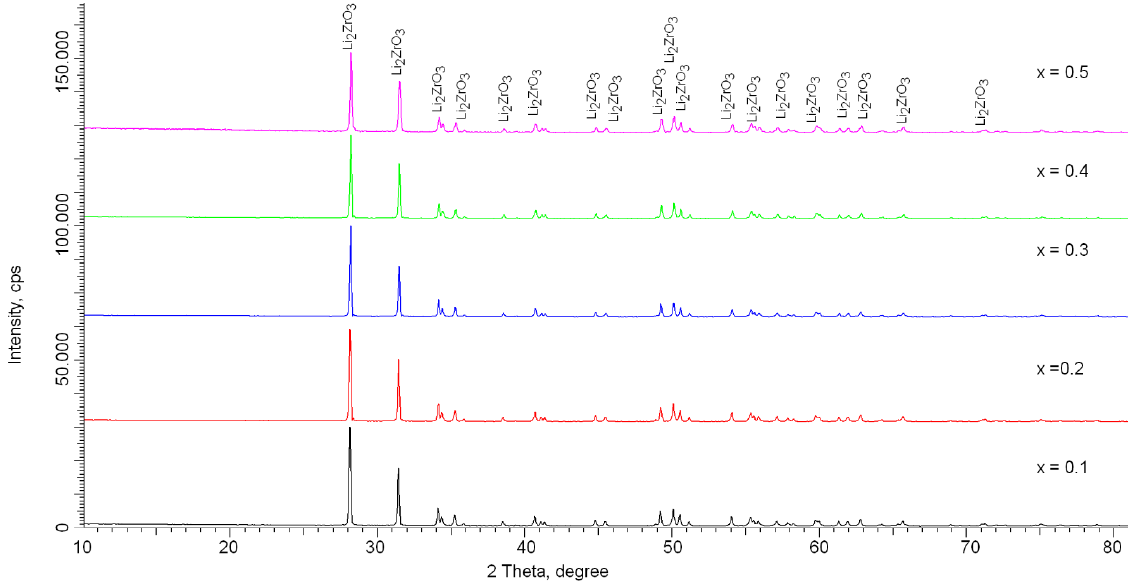
Figure 2. X-ray diffraction patterns of the studied ceramics.